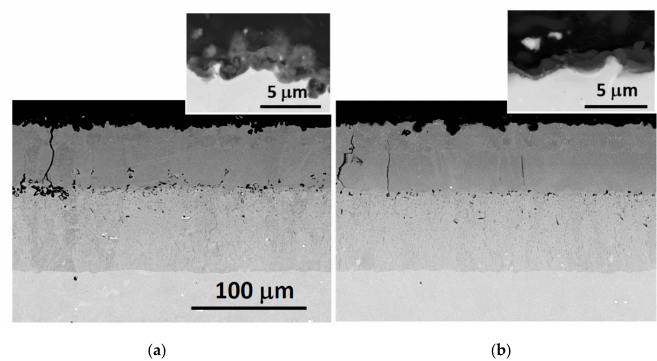
Figure 14. XRD pattern of slurry-aluminised HT347HFG steel exposed to steam at 700 °C for 3000 h under: ( a ) atmospheric pressure and ( b ) 25 MPa including a higher magnification of the low intensity peaks.